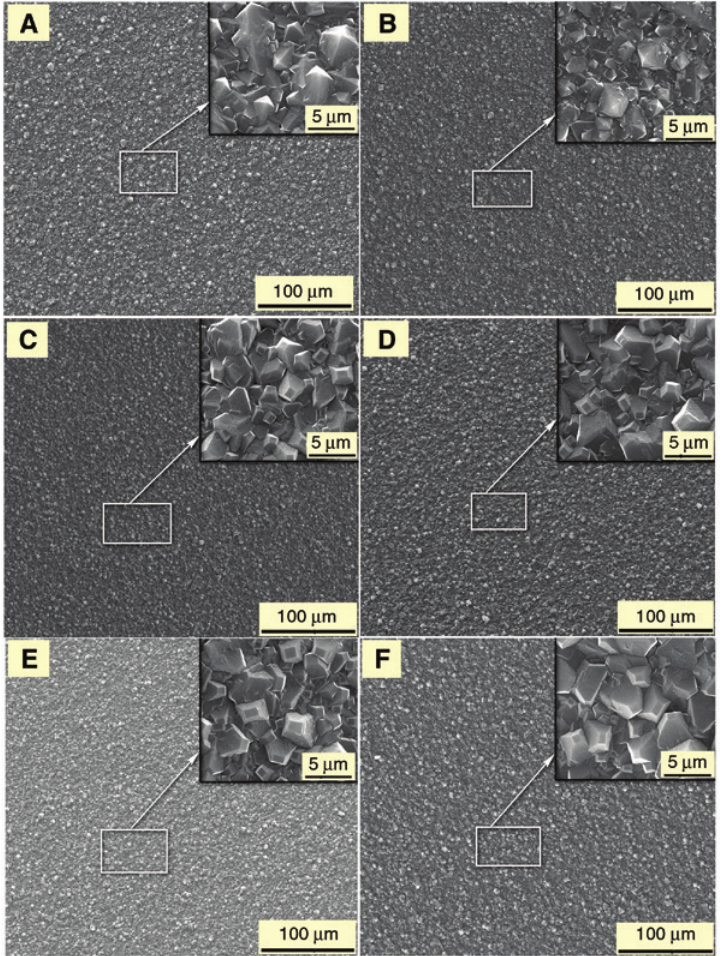
-0, Ar-0; (B) O -0, 2 2